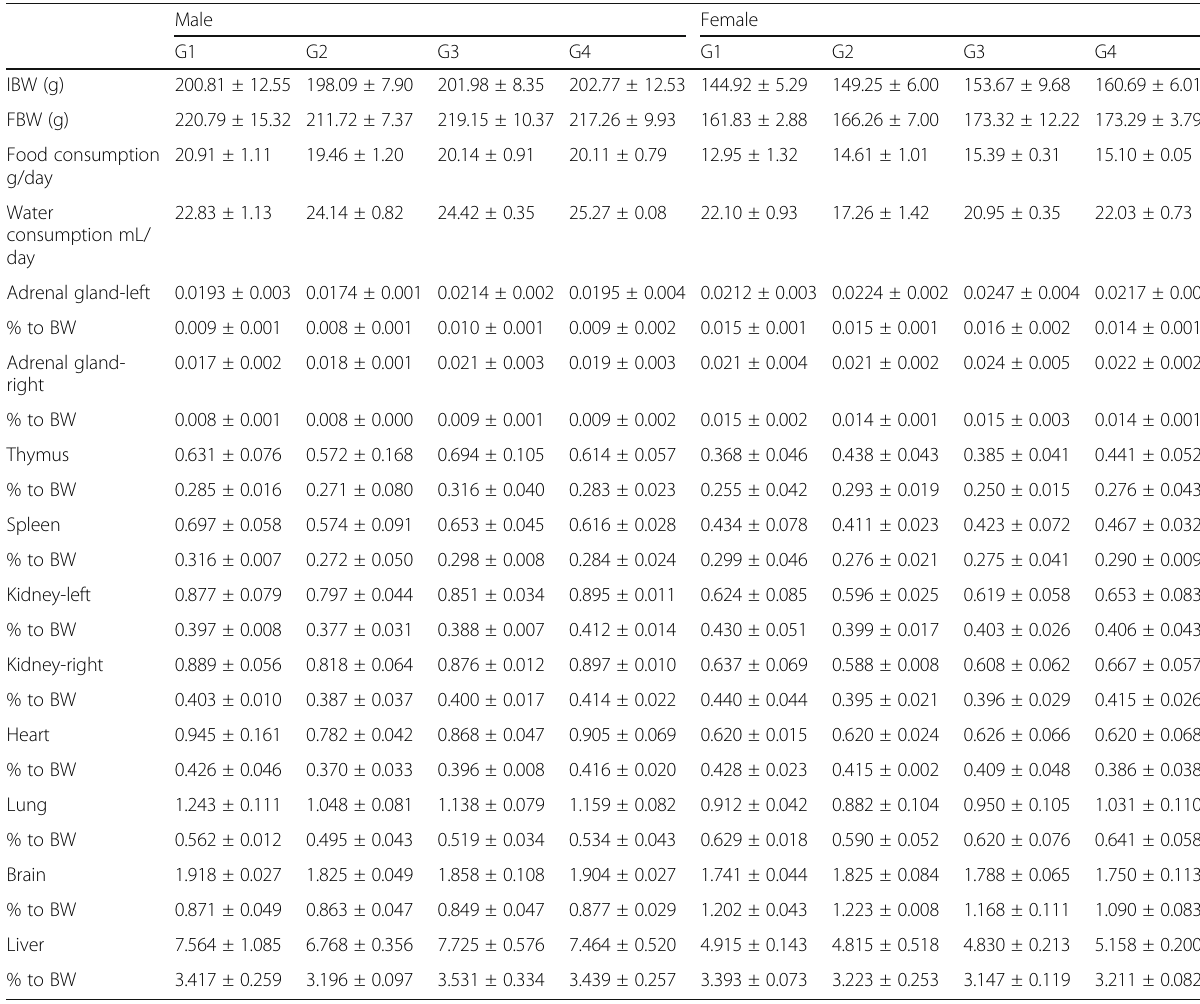
Table 1 Effect of oral administration of OE on body weight, food and water consumption, and relative organs weight to